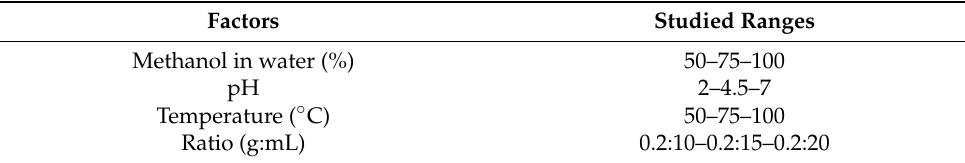
Table 1. Ranges studied for each MAE factor. Factors Studied Ranges